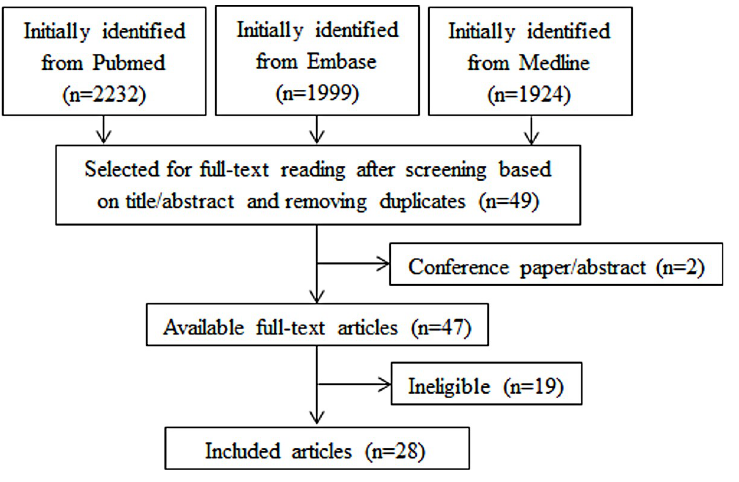
Fig 1. Flowchart of study